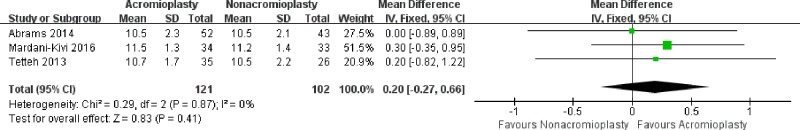
Forest plot of SST score between the treatment of acromioplasty and nonacromioplasty.